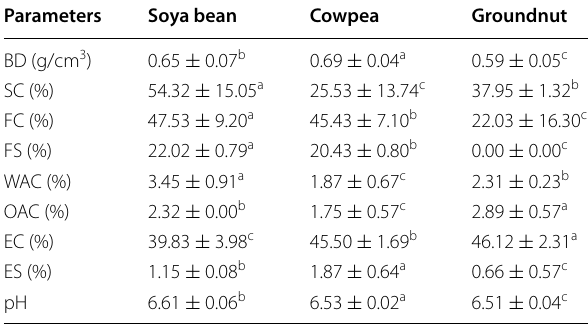
Table 1 Functional properties of legume flours used for chicken nugget